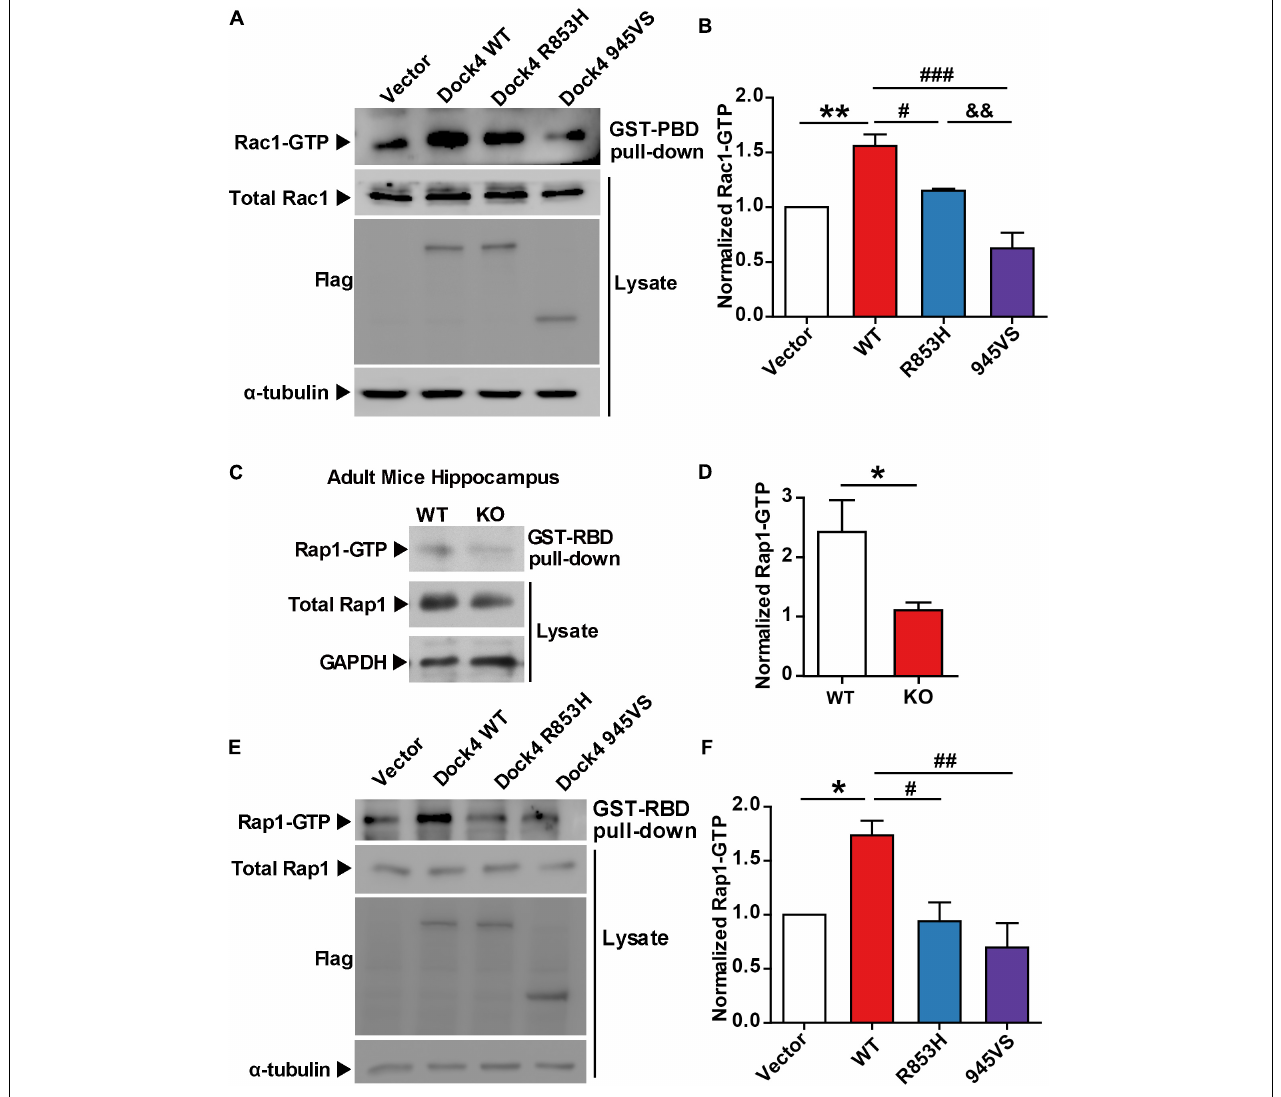
FIGURE 2 | Both 945VS and R853H mutants of Dock4 lose the GEF activities to activate Rac1 and Rap1 GTPases. (A) Rac1 activation by Dock4 mutants was abrogated. cDNAs of Dock4-R853H, Dock4-945VS, Dock4-WT (wild-type), or vector were expressed in HEK293T cells, and the levels of activated Rac1 (Rac1-GTP) were measured. (B) Rac1-GTP levels were quantified and normalized to total Rac1 levels. Data are shown as mean ± SEM from three independent experiments. ∗∗ P < 0.01, # P < 0.05, ### P < 0.001, && P < 0.01, one-way ANOVA. (C) Rap1-GTP level was reduced in hippocampus of Dock4 knockout mice. Adult WT and Dock4 knockout hippocampus protein was lysed, and the levels of Rap1-GTP were analyzed. (D) Rap1-GTP levels were quantified and normalized. Data are shown as mean ± SEM from three independent experiments. ∗ P < 0.05, unpaired t -test. (E) Dock4 mutants failed to activate Rap1. Dock4-R853H, Dock4-R853H or Dock4-WT were expressed in HEK293T cells, and the levels of Rap1-GTP were analyzed. (F) Rap1-GTP levels were quantified and normalized. Data are shown as mean ± SEM from three independent experiments. ∗ P < 0.05, # P < 0.05, ## P < 0.01, one-way